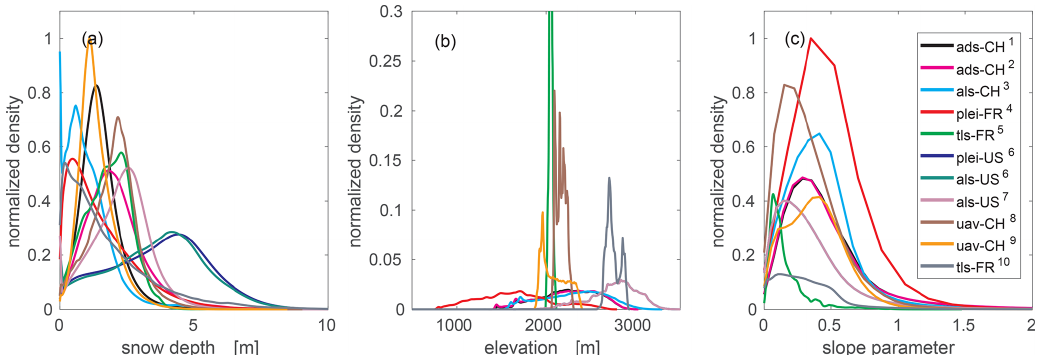
Figure 2. Probability density functions for fine-scale (a) snow depth, (b) elevation and (c) squared-slope-related parameter per observation data set in its original horizontal resolution, i.e., between 0.1 and 3m. Densities were normalized with the corresponding maximum density of all data sets. Note that for elevation (b) the y axis was cut for better visibility. Colors represent the different geographic regions, measurement platforms or acquisition dates (number) of the compiled data set as indicated in Sect. 2.1 to 2.4.